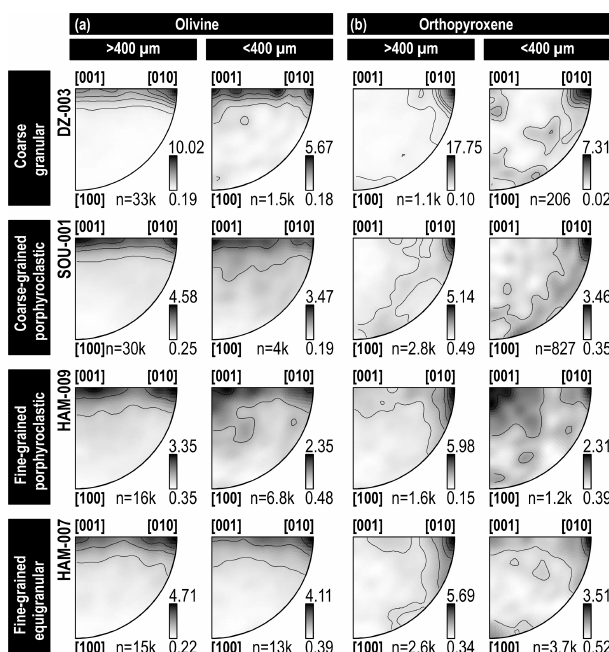
Figure 6. Rotation axes accommodating low-angle (2–12 ◦ ) mis- orientations in the large (>400µm equivalent diameter) and small (<400µm equivalent diameter) grain fraction of olivine (a) and or- thopyroxene (b) . Data are represented in inverse pole figures with contouring at 0.5 multiples of uniform distribution. N denotes the number of pixels